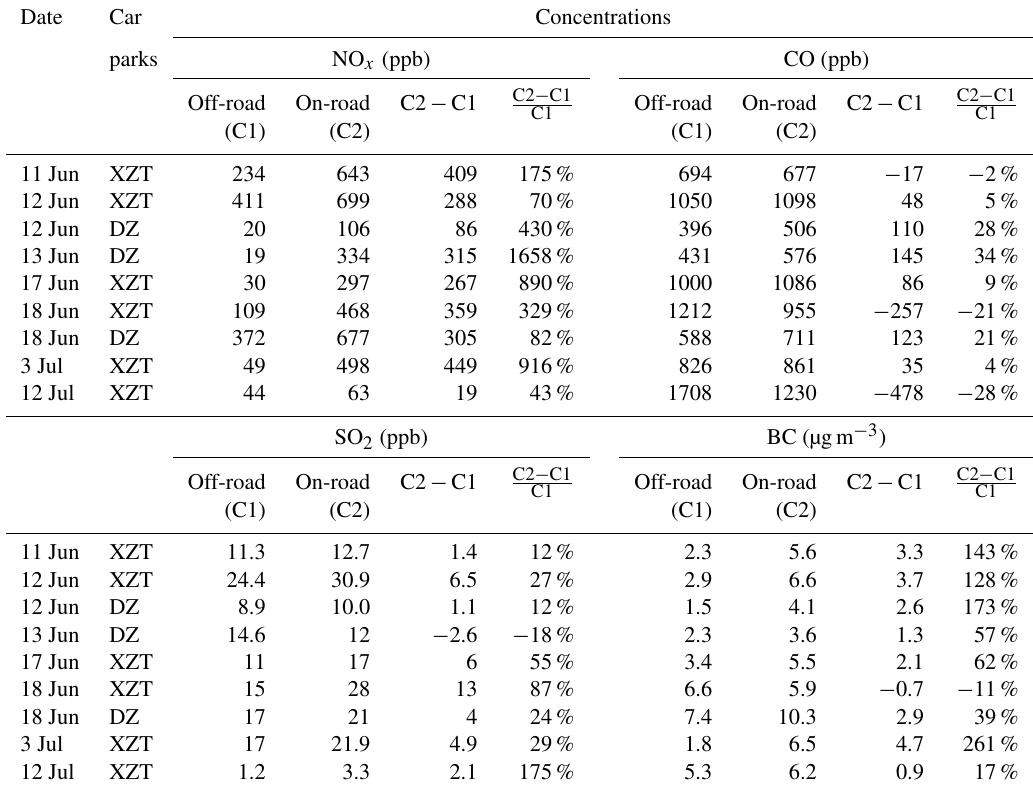
Table 2. The concentrations of NO x , CO, SO 2 and BC measured in car parks and motorways, and the concentration differences between off-road and on-road